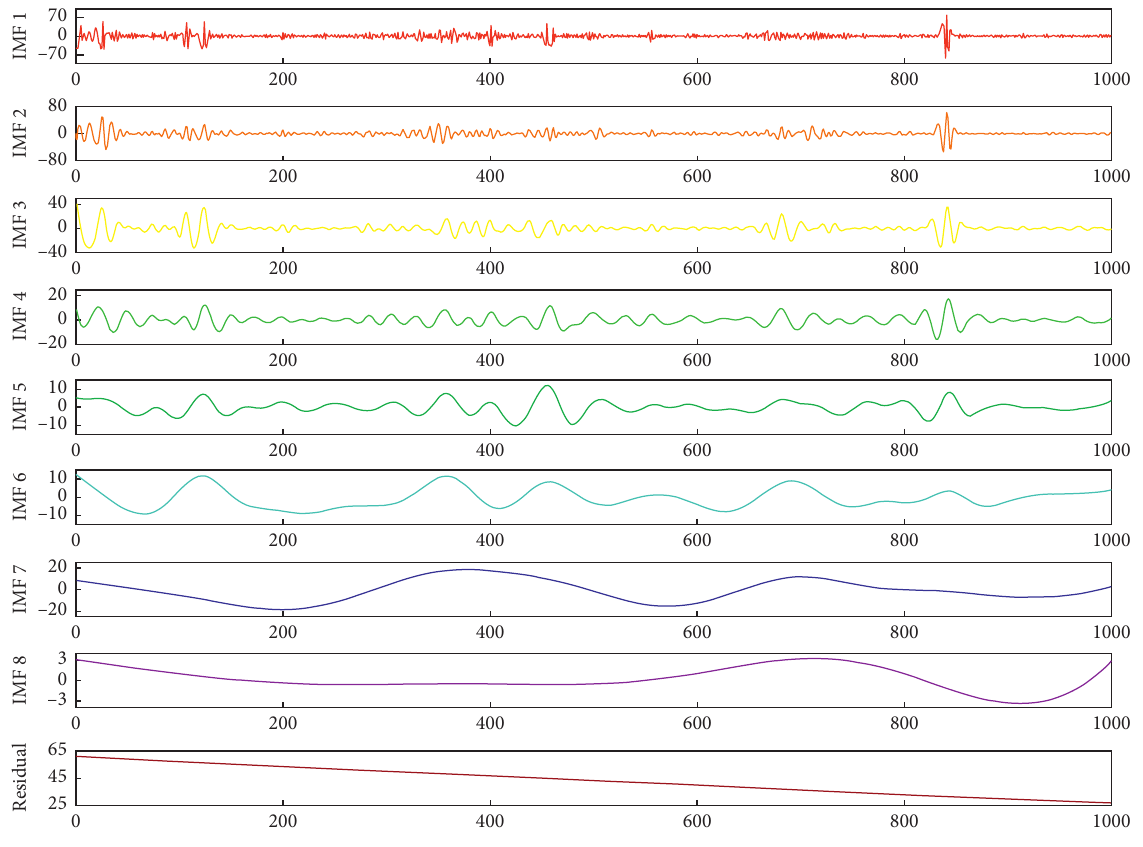
Figure 3: The IMFs and a residue term of PM 2.5 concentration data in Lanzhou city via EEMD Table 2: The forecasting results of single models.